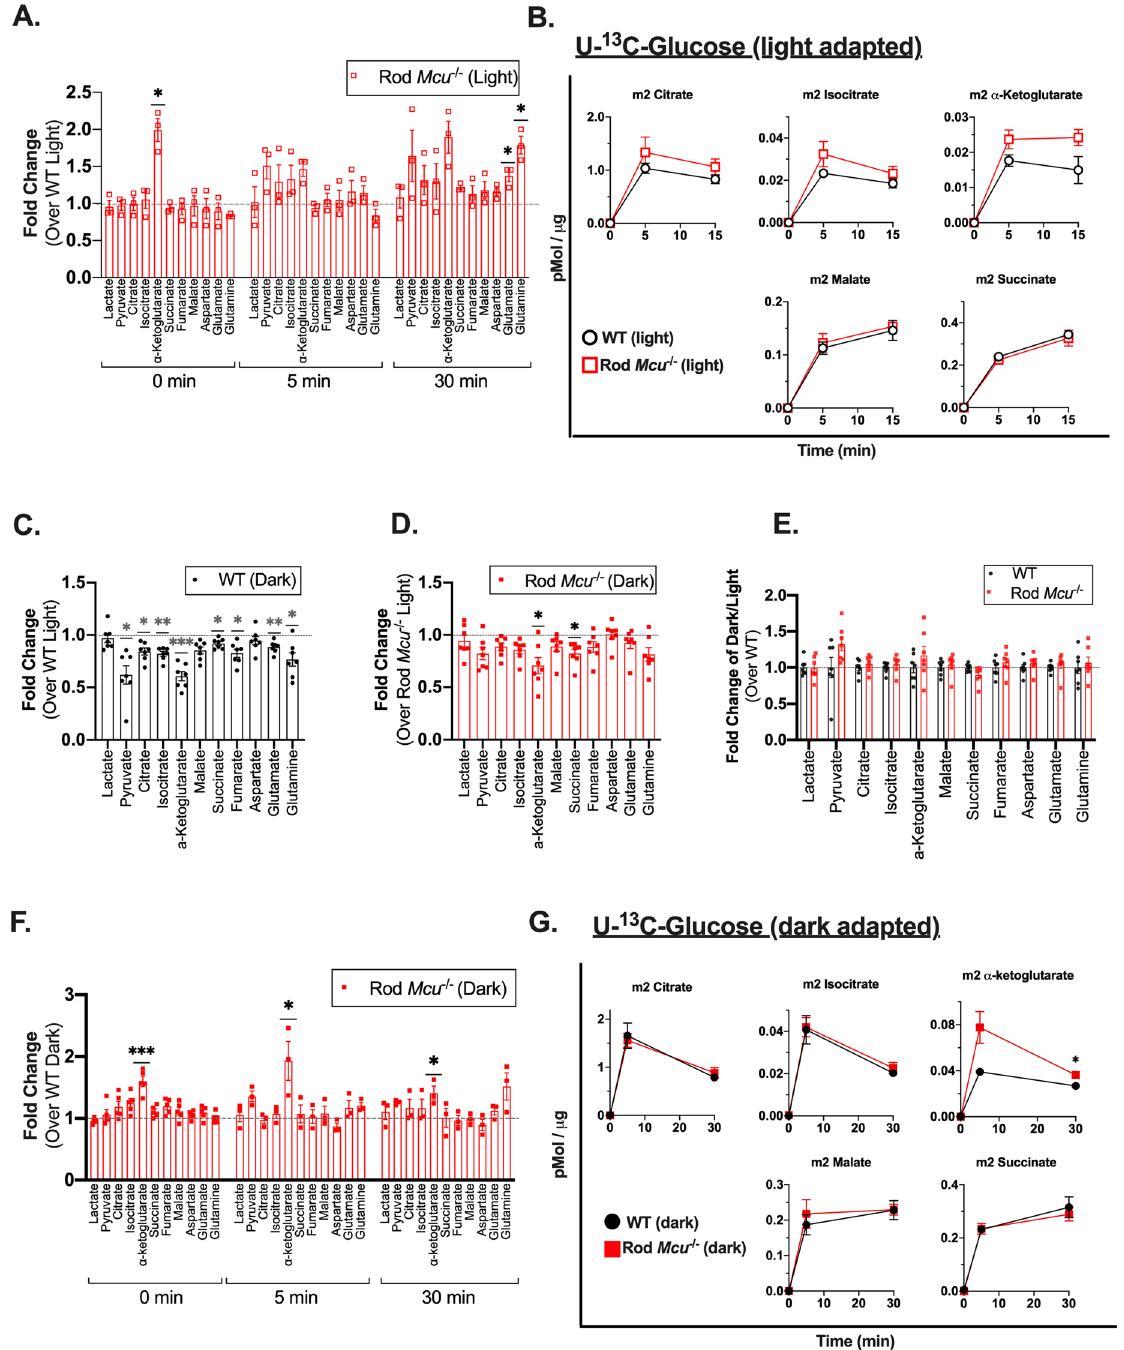
Figure 5. Loss of MCU leads to a buildup of α-ketoglutarate in Rod Mcu -/- retinas. ( A ) Total metabolite levels in light-adapted Rod Mcu -/- retinas relative to WT (n = 3 WT and 3 Rod Mcu -/- retinas per time point. Each time point used retinas from 3 different animals (*indicates p < 0.05 using Welch’s t test). ( B ) Time course of labeled metabolite accumulation in light-adapted WT and Rod Mcu -/- retinas incubated in U- 13 C-glucose for 0, 5, and 15 min (n = 3 WT and 3 Rod Mcu -/- retinas per time point. Each time point used retinas from 3 different mice. ( C ) Total metabolite levels in dark-adapted WT retinas relative to light-adapted WT retinas (n = 4 light adapted retinas and 7 dark adapted retinas, each from four different mice. *indicates p < 0.05, **indicates p < 0.01, ***indicates p < 0.001 using Welch’s t test). ( D ) Total metabolite levels in dark-adapted Rod Mcu -/- retinas relative to light-adapted Rod Mcu -/- retinas (n = 6 light adapted retinas and 7 dark adapted retinas, each from four different mice. * indicates p < 0.05 using Welch’s t test). ( E ) Change in metabolite abundance between darkness and light in Rod Mcu -/- retinas relative to WT retinas from Fig. 4C, D. (n = 4 light adapted WT retinas, 7 dark adapted WT retinas, 6 light-adapted Rod Mcu -/- retinas, and 7 light-adapted Rod Mcu -/- retinas, all ns using Welch’s t test). ( F ) Total metabolite levels in dark-adapted Rod Mcu -/- retinas relative to WT (n = 4 WT and 5 Rod Mcu -/- retinas for t = 0, n = 3 WT and 3 Rod Mcu -/- retinas for t = 5 and t = 30. Each time point used retinas from at least 3 different animals. *indicates p < 0.05, *** indicates p < 0.001 using Welch’s t test). ( G ) Time course of dark-adapted WT and Rod Mcu -/- retinas incubated in U- 13 C-glucose for 0, 5, and 30 min (n = 3 WT and 3 Rod Mcu -/- retinas per time point. Each time point used retinas from 3 different animals. *indicates p < 0.05 using Welch’s t